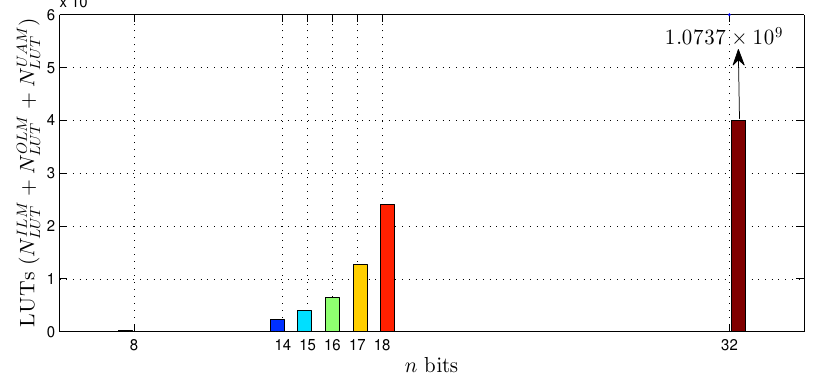
Figure 12. Area occupied (LUTs) for different fixed point formats, in the sine function scenario.